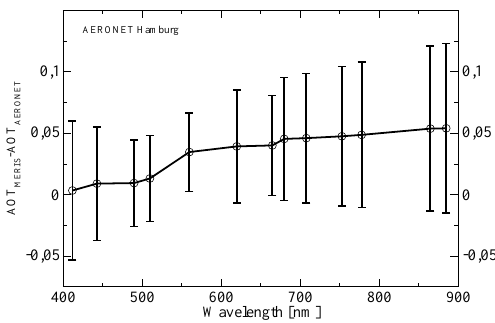
Fig. A3. Phase functions as derived from the L ACE -98 experiment; A ERONET Hamburg 870nm for fine, coarse and overall aerosols.